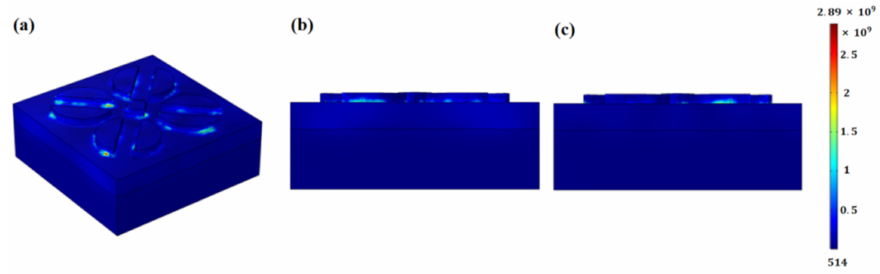
Figure 7. Electric field distribution at the absorption peak f 4 = 743 THz. ( a ) Axonometric view of the electric field. ( b , c ) Side views of the electric